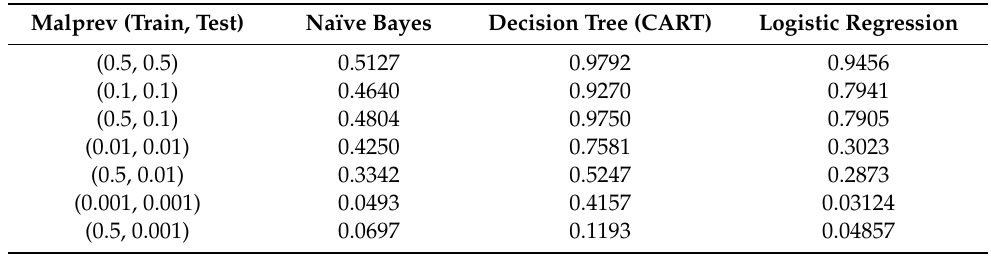
Table 4. Experimental results according to naïve Bayes, decision tree, logistic regression using PE file format.